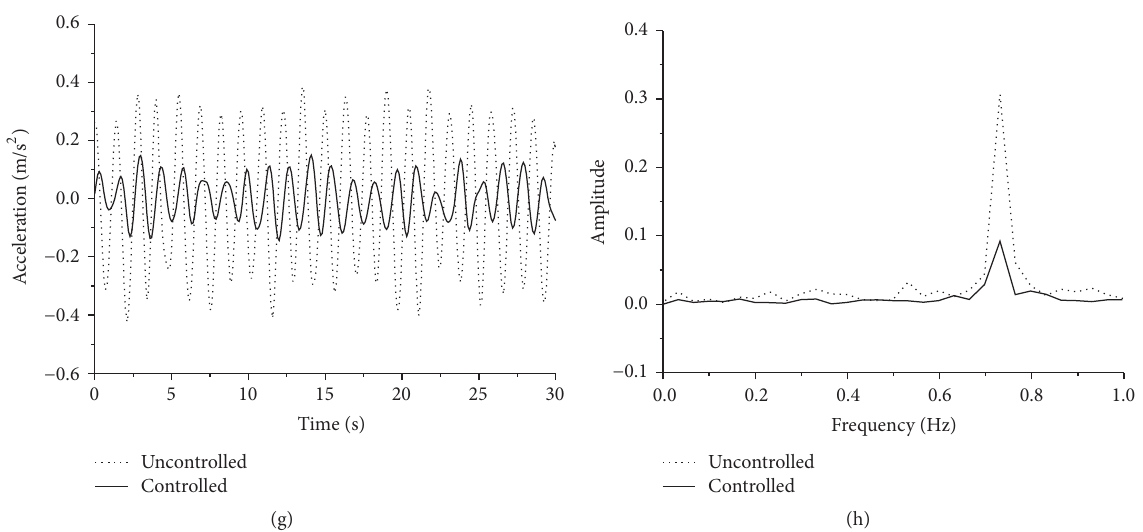
Figure 9: Comparison of acceleration responses to 4th floor of the experimental system. (a) and (b) 4-order model, (c) and (d) 6-order model, (e) and (f) 8-order model, and (g) and (h) full-order model.